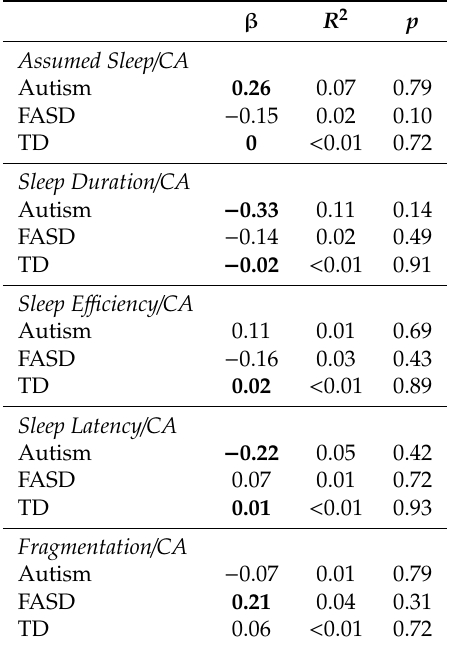
Table 3. Nonsignificant